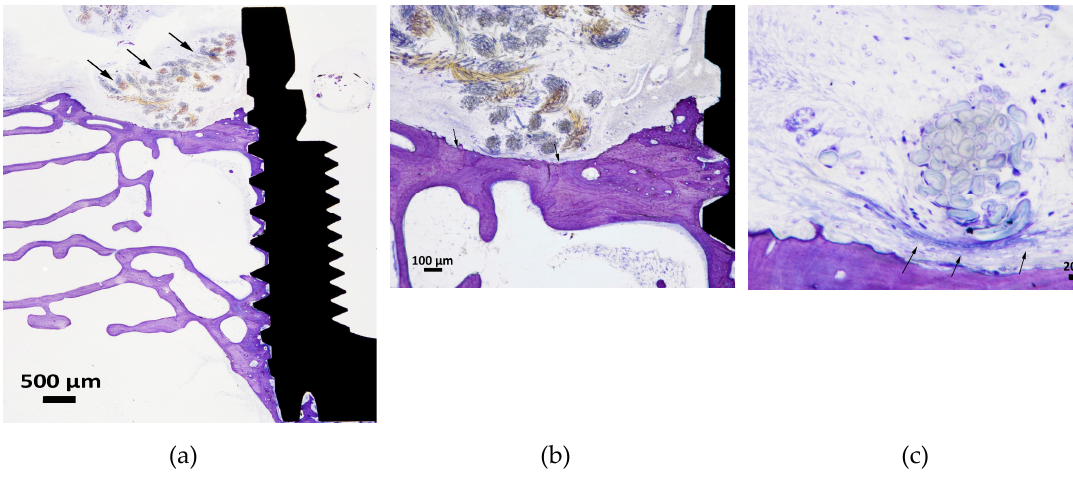
Figure 7. Three images from one cotton section with arrows showing the cotton ligature. ( a ) An illustration of a typical section with cotton suture situated above the periosteal bone. ( b ) The periosteal bone surface is separated from the cotton ligature by a soft tissue layer and the bone surface appears to be resorbed (arrows), although no osteoclasts could be observed. ( c ) The amount of macrophages in the soft tissue between the bone and the cotton seemed to be less compared to the silk sections. However, macrophages were visible as being more spread out and “darker” compared to silk samples. None of the cotton samples demonstrated a typical MNGC formation and the “encapsulation” of cotton was often loosely arranged (arrows).